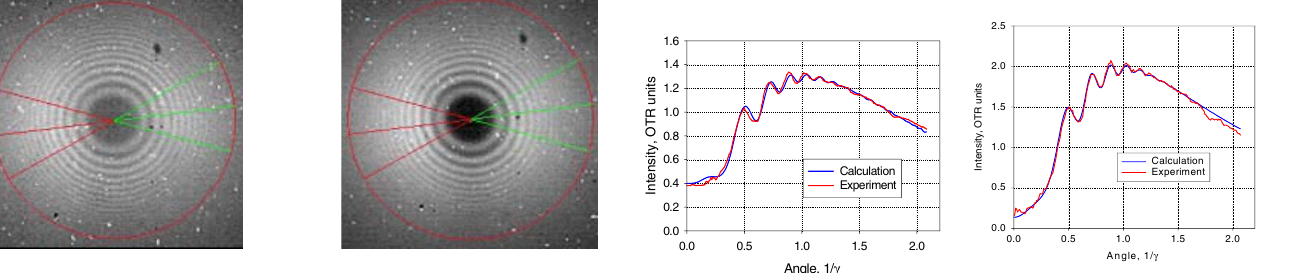
FIG. 18. (Color) Averaged line scans of ODTRI (left) and OTRI (right) corresponding to Fig. 17.